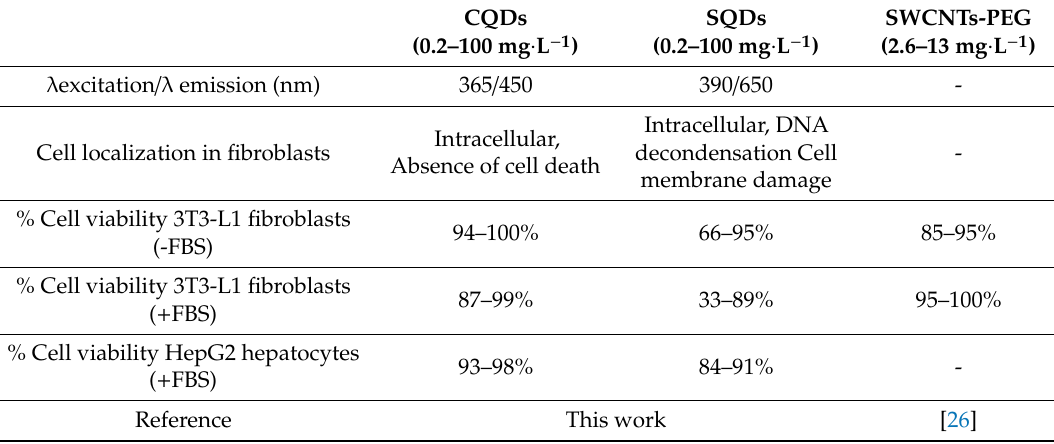
Table 1. Comparison of the main toxicological results of our proposal vs. literature.